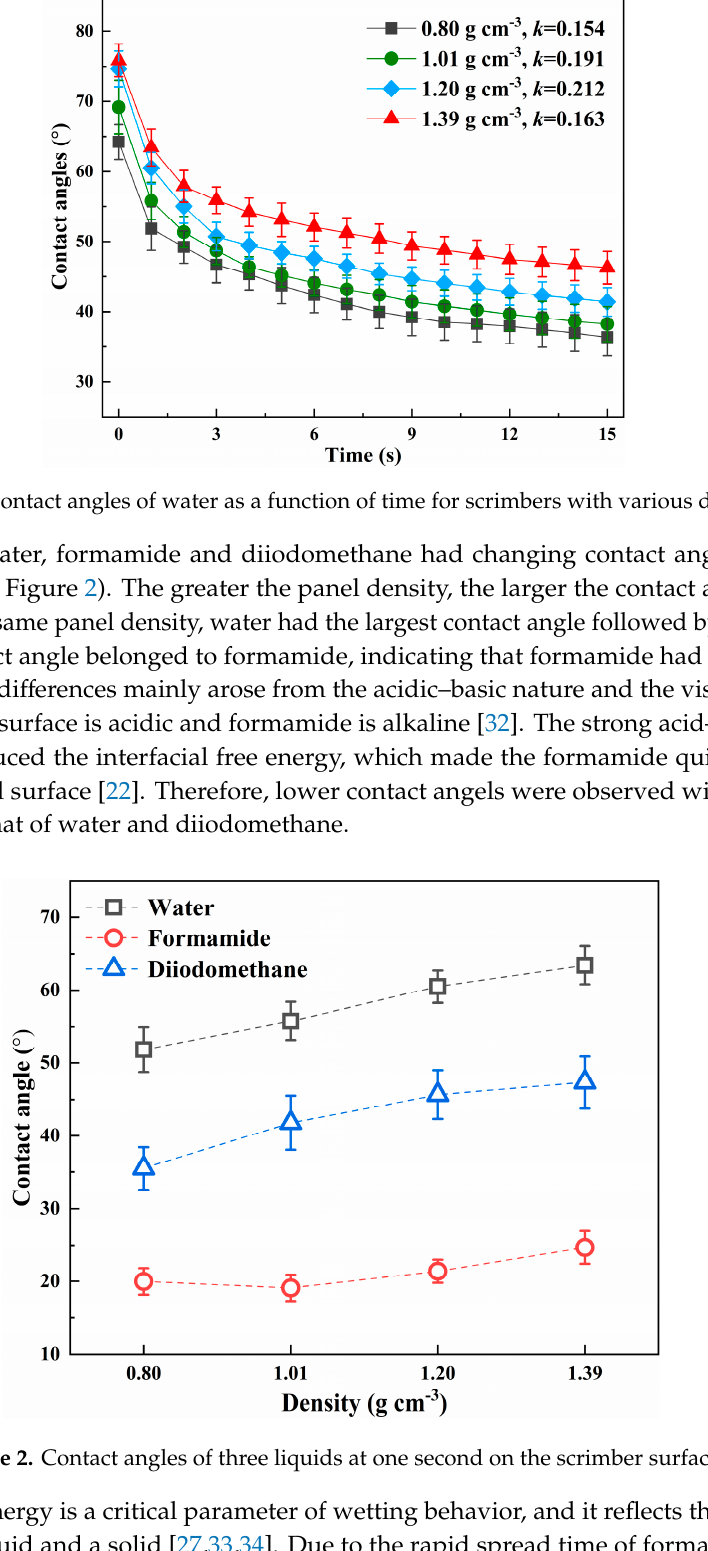
Figure 2. Contact angles of three liquids at one second on the scrimber surfaces.